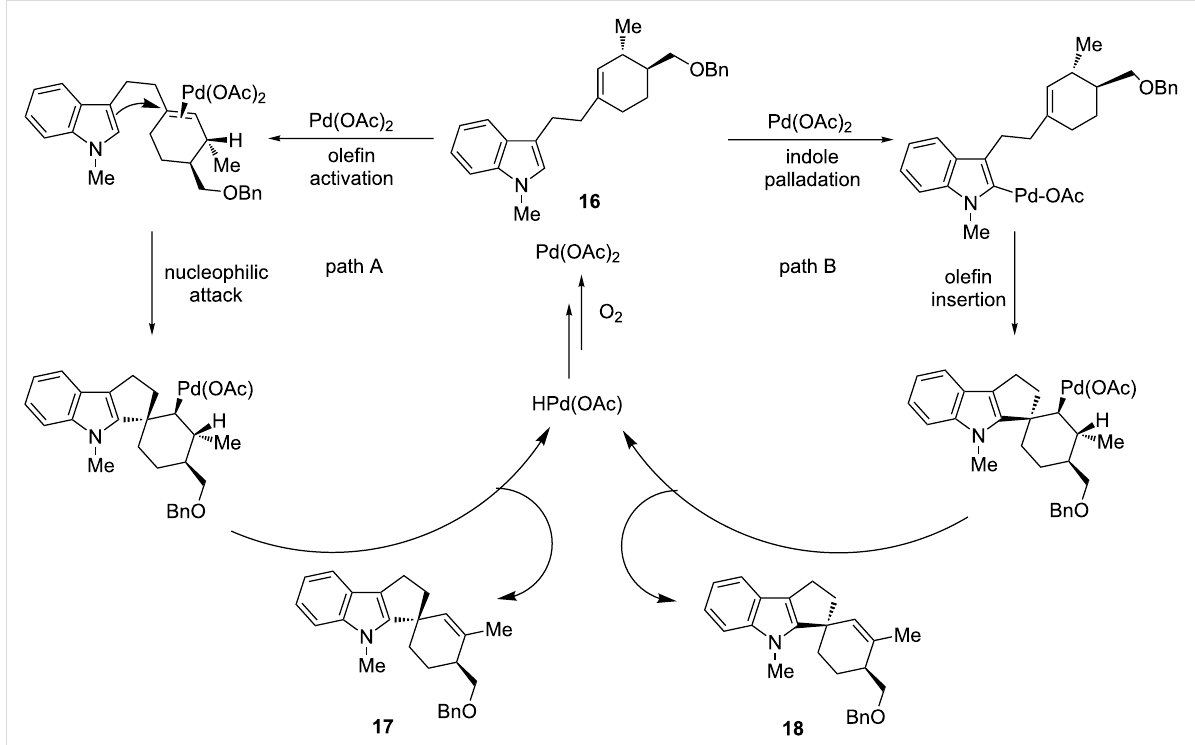
Scheme 13: A mechanistic probe for intramolecular annulations of alkenylindoles, adapted from Ferreira et al. [66].